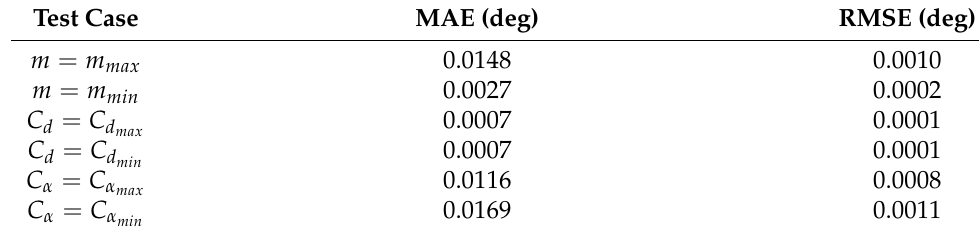
Table 9. MAE and RMSE for e 2 .